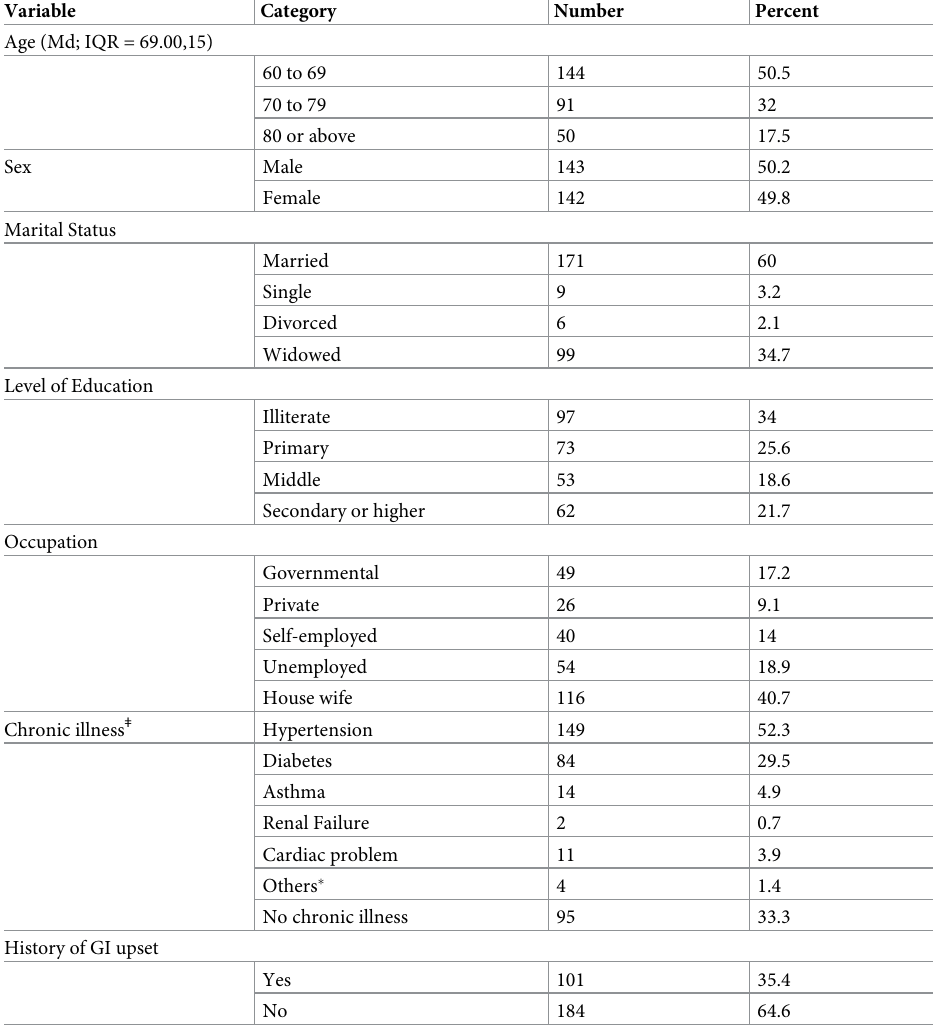
Table 1. Socio-demographic and background characteristics of the respondents (N = 285).